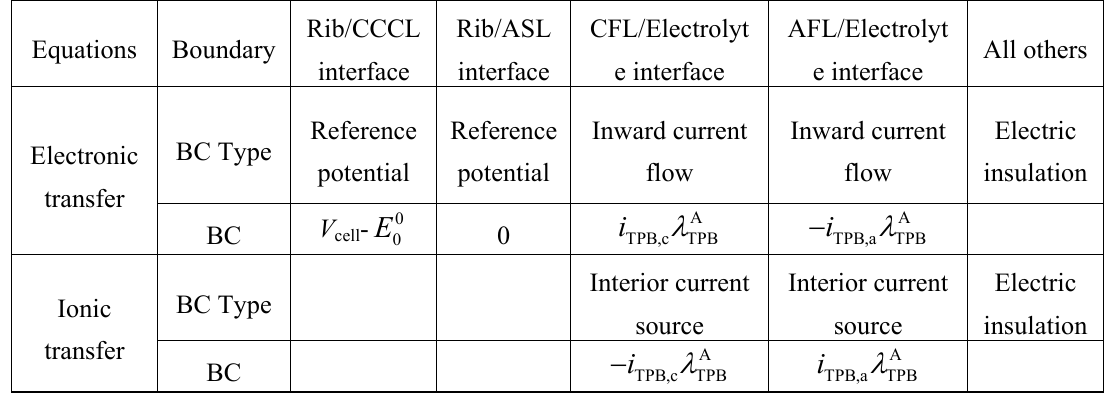
Table 3. Boundary settings for the electronic and ionic charge transfer